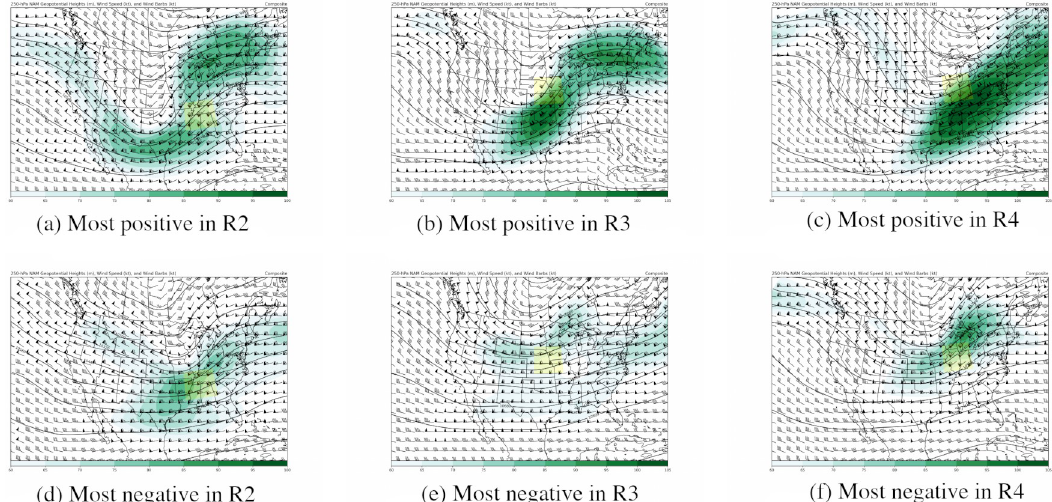
Fig 4. Composite maps of 250 hPa geopotential heights (contoured), 250 hPa wind speed (shaded) and 250 hPa wind direction (wind barbs) associated with the ageostrophic circulation mode (ACM) over regions R2, R3 and R4. Each map corresponds to (a-c) the ten most positive values (d-f) the ten most positive values for regions (left) R2, (middle) R3, and (right) R4. The yellow- shaded box is the corresponding study region.